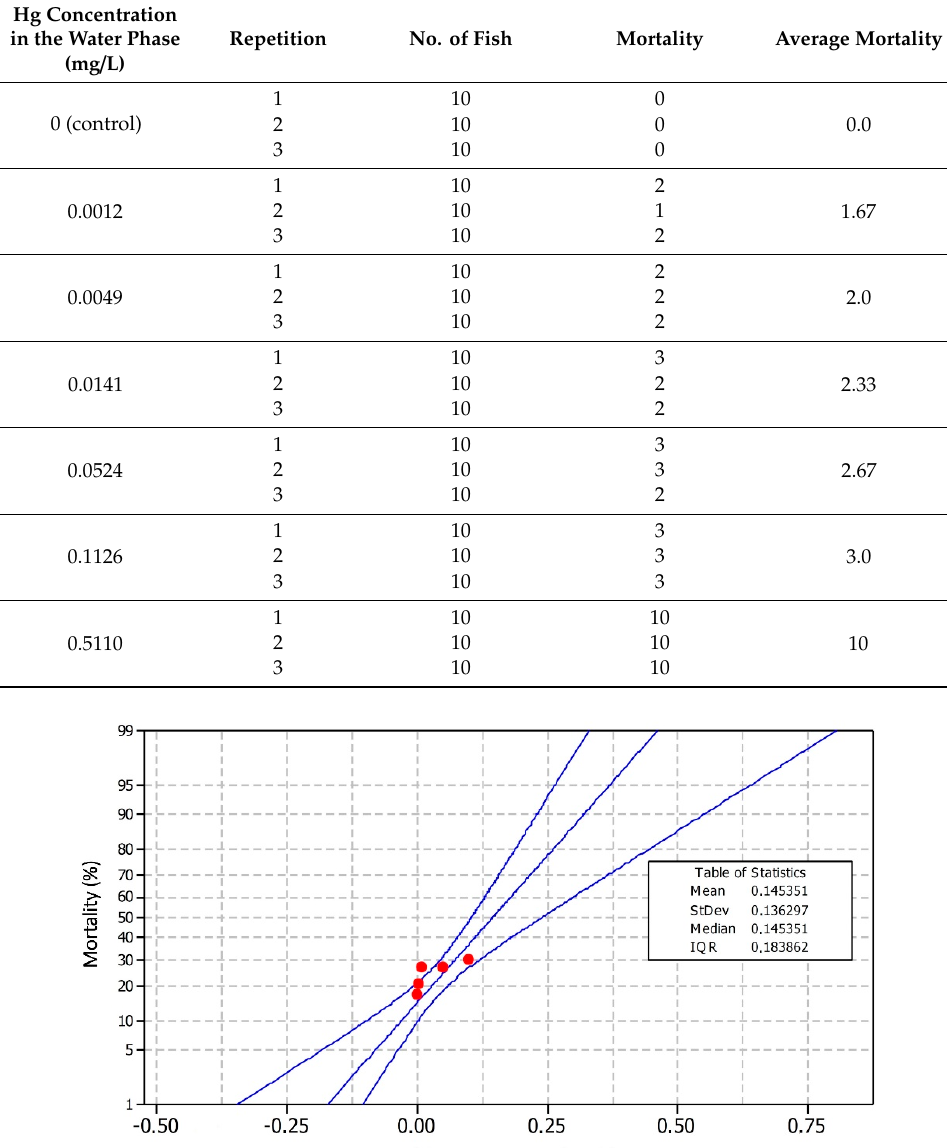
Table 1. Mortality of freshwater fish (Oreochromis niloticus) during 72 h toxicity test.